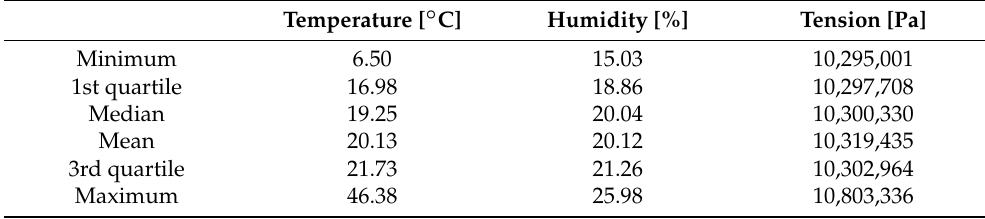
Table 1. Summary statistics for temperature, humidity and pressure globally for all 26-time